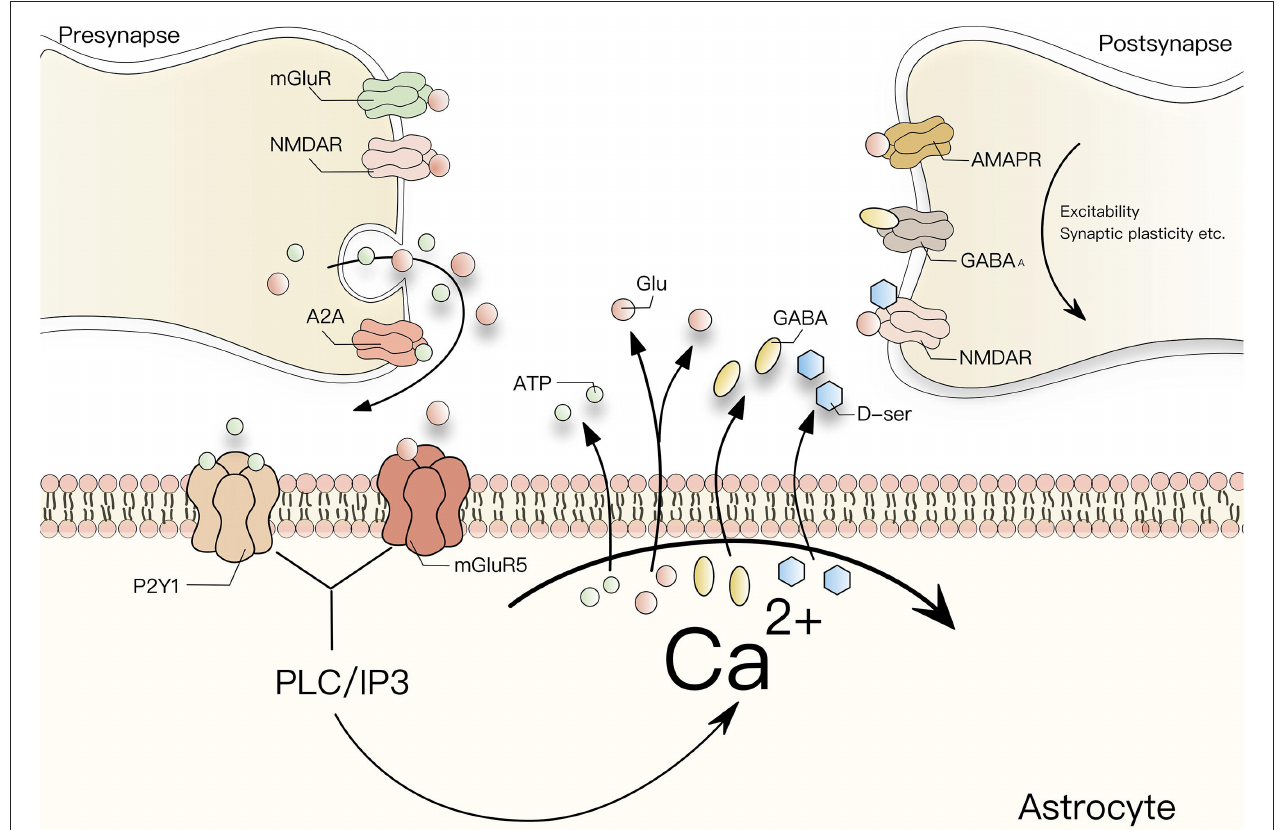
FIGURE 1 | Interaction between Ca 2 + and glial transmitters. G-protein-coupled receptors activated by glutamate, GABA, and ATP can increase [Ca 2 + ] i in astrocytes through the PLC/IP3 signal cascade. The increase of [Ca 2 + ] i can in turn enhance the release of glial transmitters such as glutamate, GABA, ATP or D-ser by astrocytes and influence the excitability, synaptic plasticity, and synaptic electrophysiology of postsynaptic neurons. Among them, glutamate induces an NMDAR-mediated inward membrane current in neurons to regulate synaptic excitability and synchronize its action potential. ATP mainly activates the P2y1 receptor from the P2 receptor family, which increases [Ca2 + ]i, and the release of D-ser also plays a similar role by binding with NMDAR. And astrocytes increase the transmission efficiency of CA1 pyramidal cells by activating the subtype 5 metabotropic glutamate receptor (mGluR5) and presynaptic adenosine A2A receptor, resulting in the upregulation of synaptic transmission and induction of LTP At the same time, D-ser controls the activation of NMDA receptors when glutamate is released from